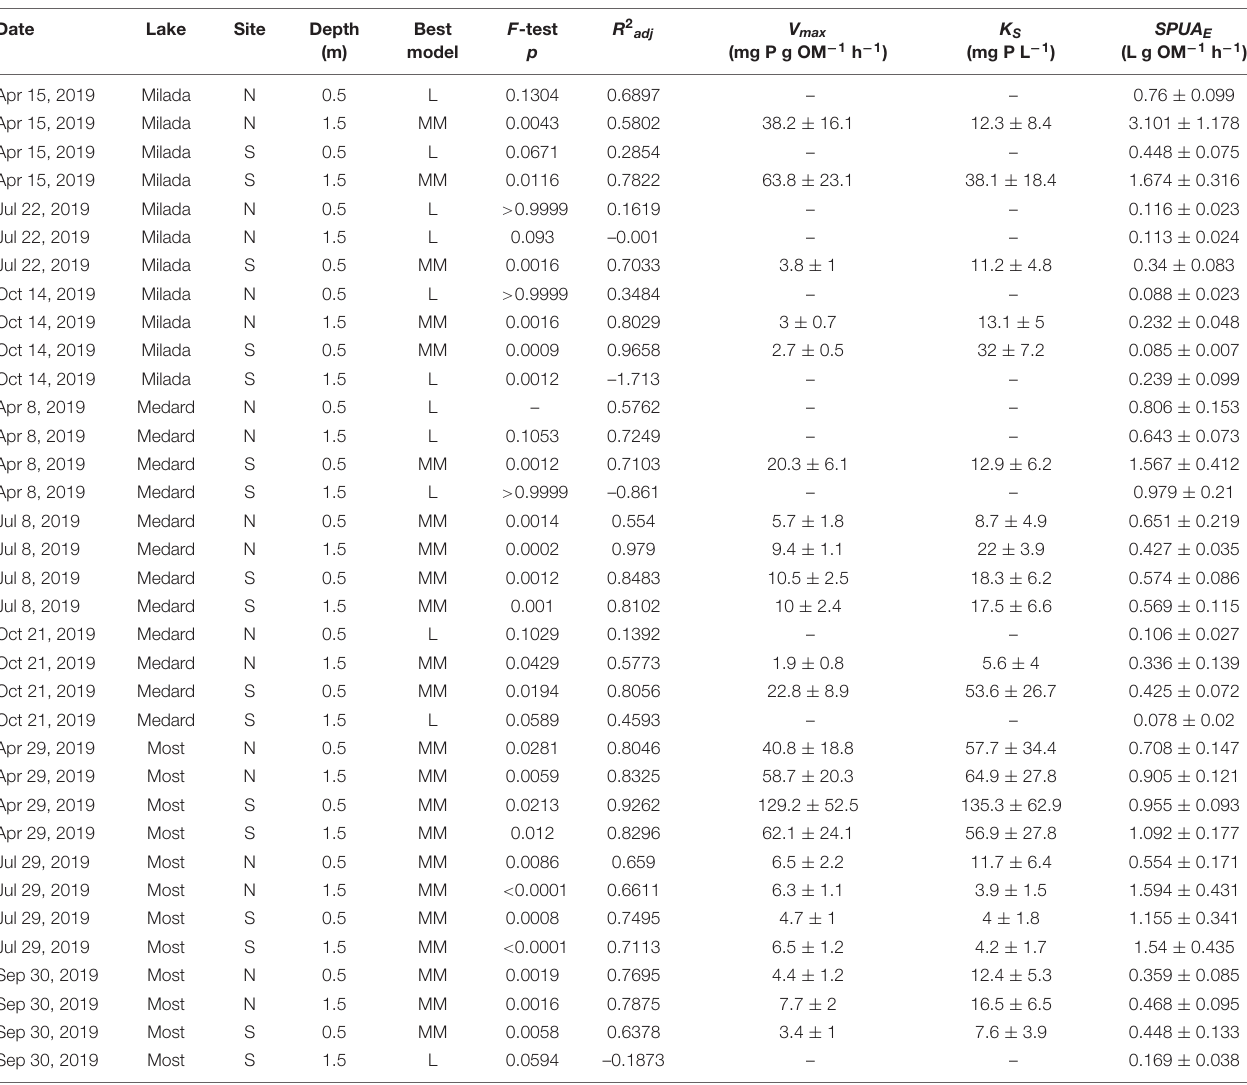
TABLE 3 | A summary of estimates of kinetic parameters of P uptake by epilithon in three post-mining lakes in the Czech Republic in 2019 with indices of the goodness of